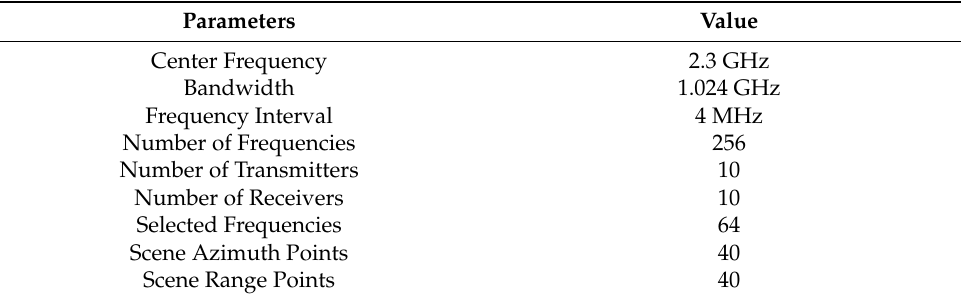
Figure 7. Optical images of experimental scenes. ( a ) MIMO radar mounted on the UGV ( b ) UGV in the fog. ( c ) Diagram of corner reflectors distribution. ( d ) Optical images of three corner reflectors in a smoky scene.